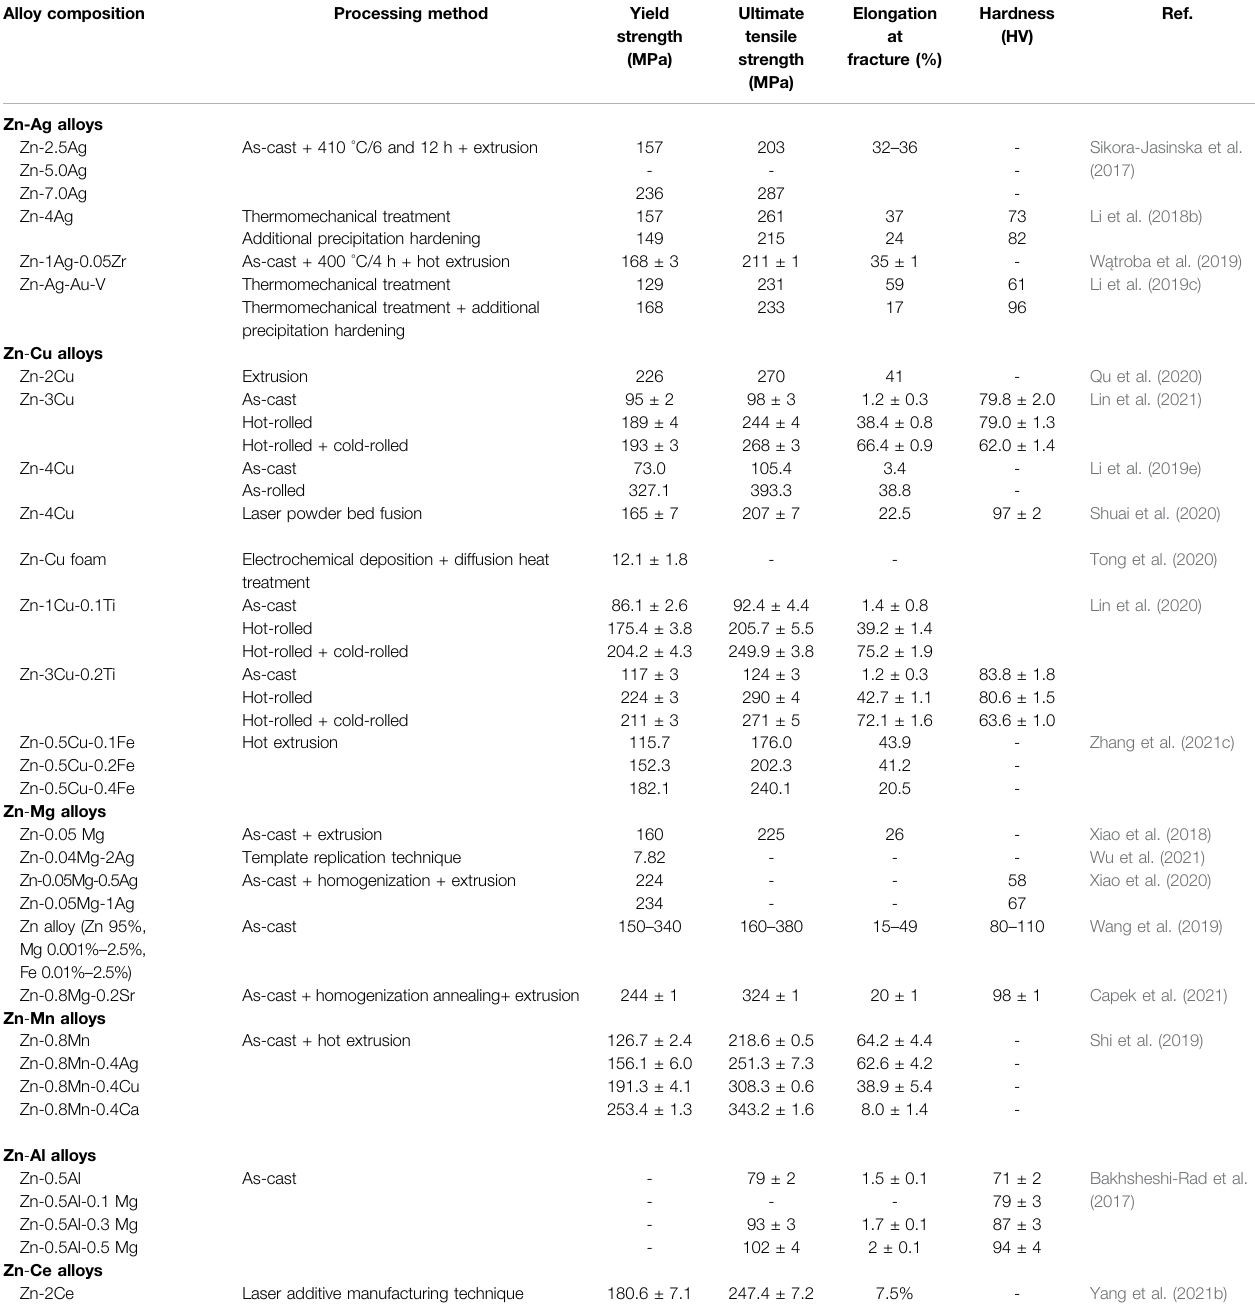
TABLE 10 | Mechanical properties of Zn-based alloys with antibacterial properties as orthopedic implants. Alloy